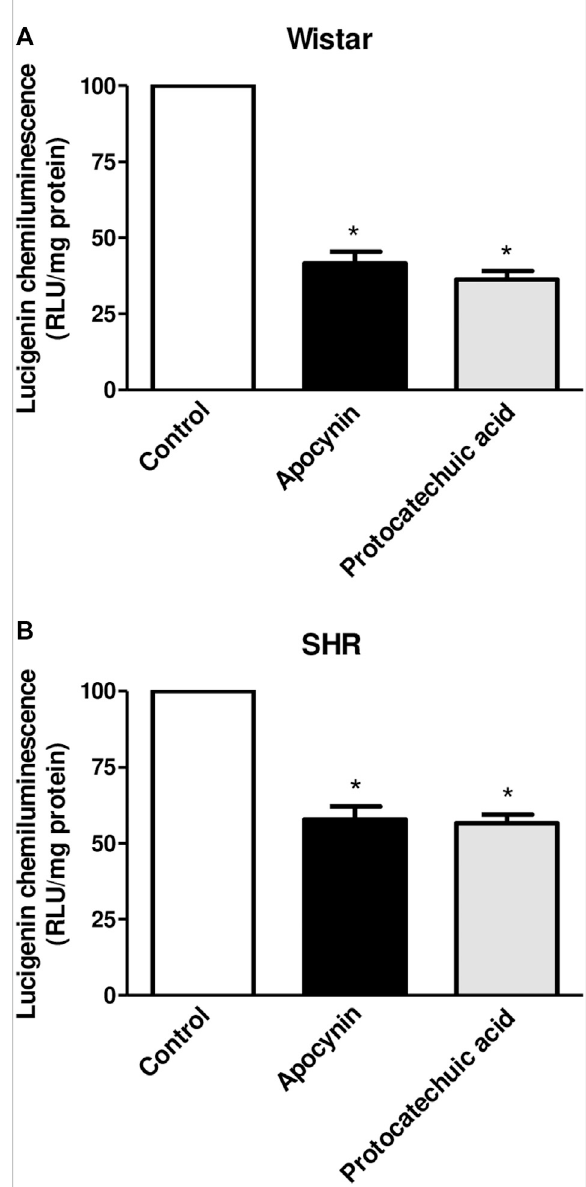
FIGURE 5 Percentage of lucigenin chemiluminescence, in relative light units(RLU/mgprotein),inaorticringsunstimulated(Control,white bars), or stimulated (100 μ mol/L) with apocynin (black bars) or protocatechuic acid (grey bars) from Wistar rats (A) and SHR (B) . Values represent themean ± SEM of the results, n = 9 – 10.* p < 0.05 Apocynin and Protocatechuic acid vs.